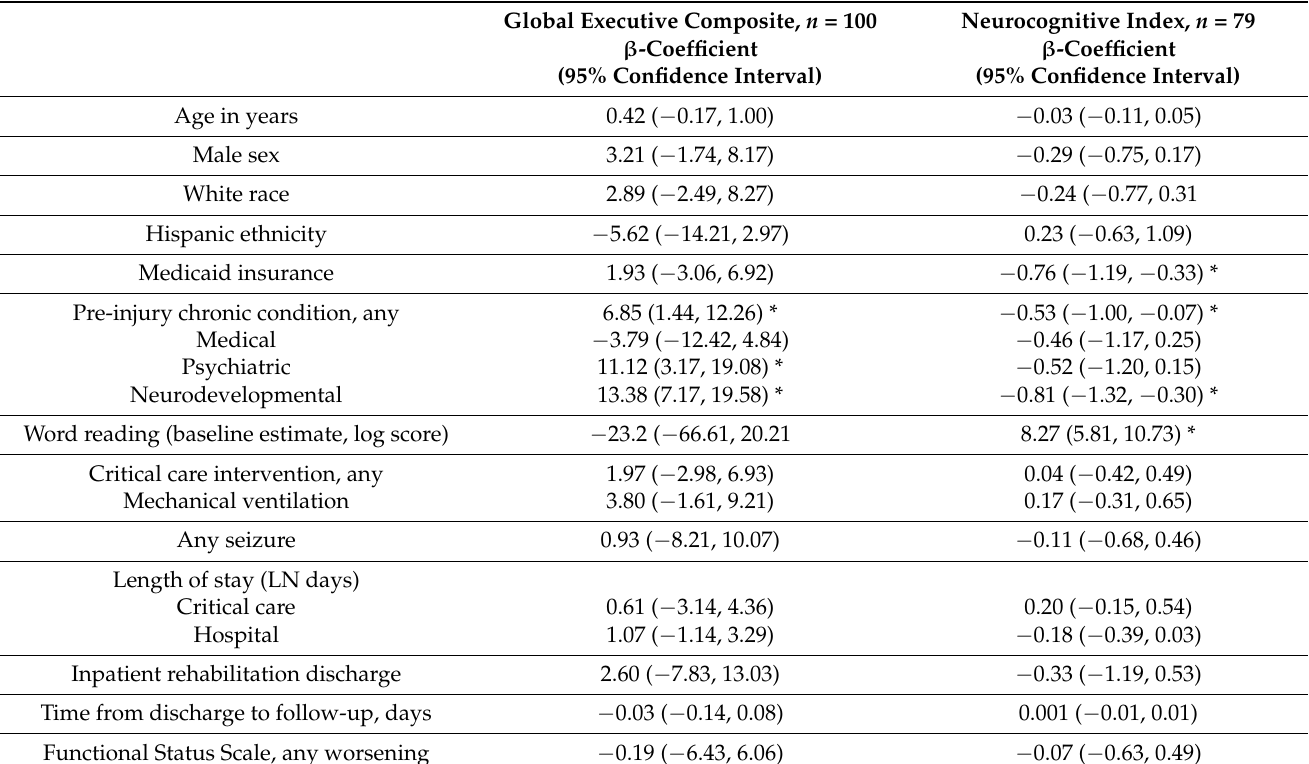
Table 3. Association between cognitive outcomes and demographic and clinical characteristics using simple linear regression for each